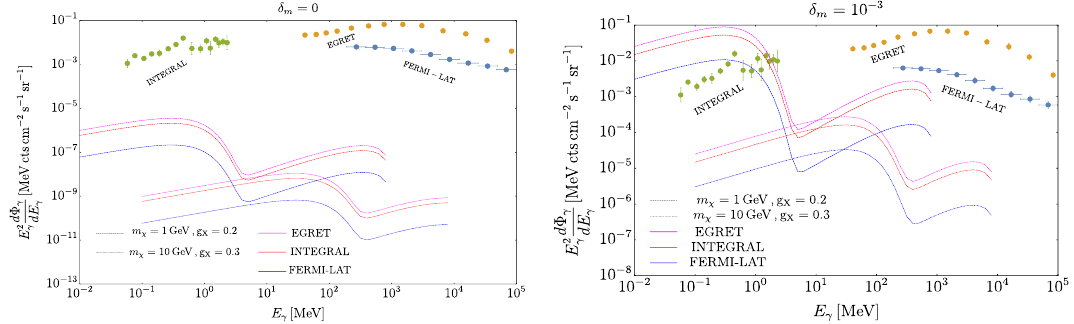
Figure 12 . Variation of differential γ -ray flux from dark matter annihilation as a function of energy of the emitted photons for two different benchmark points, allowed from relic density constraint. Left panel : γ -ray flux from dark matter annihilation is compared with the flux of diffuse γ ray background by EGRET, Fermi-LAT and INTEGRAL collaboration. Here magenta, red, and blue lines indicate the flux is calculated for the ROI of EGRET, INTEGRAL and Fermi-LAT data respectively. The flux for m = 1 GeV , g = 0 . 2 is denoted by the dashed lines and the same for m χ X 0 . 3 is denoted by the dotted lines. Here we have considered δ the color code is same as the left panel and we have considered δ